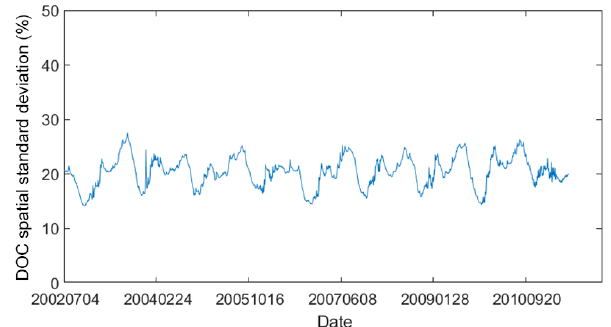
Figure 6. Spatial standard deviation of estimated degree of cur- ing (DOC) time series from 4 July 2002 to 26 June